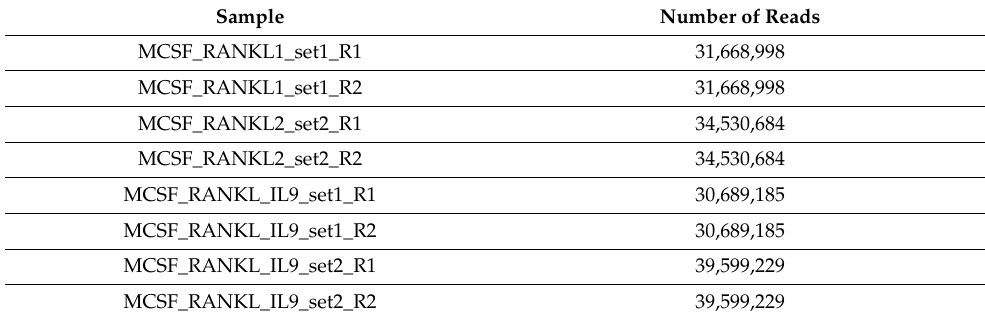
Table 3. The number of clean reads in the MCSF + RANKL- and MCSF + RANKL + IL-9-treated group.